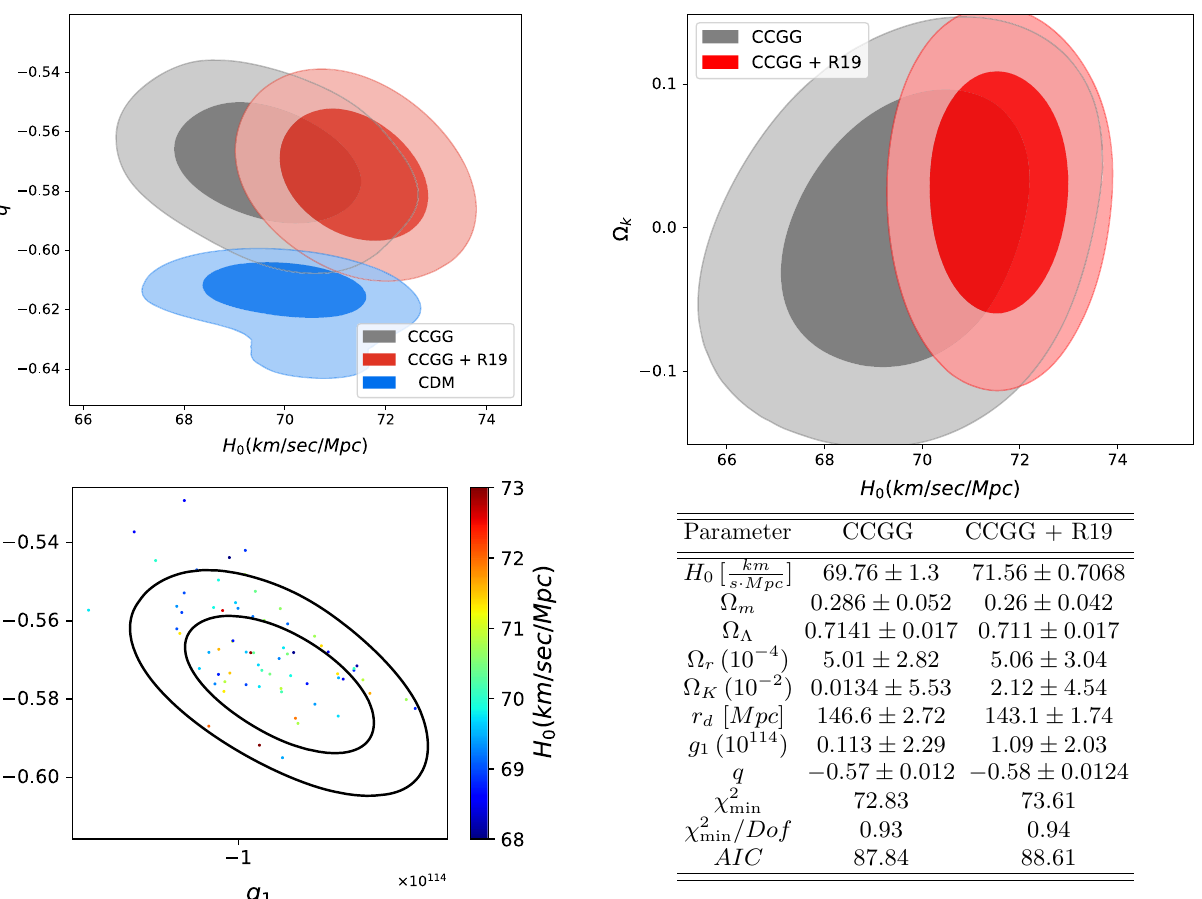
Fig. 5 One- (68% CI) and two-dimensional (68% and 95% CI) marginalized posterior distributions for the the deceleration parameter (cid:12) K vs.theHubbleparameter H 0 .ThegraycontourdescribestheCCGG best fit with a uniform prior. The red contour describes the CCGG best fit with the SH0ES measurement as a prior.The table shows Observa- tional constraints and the corresponding χ 2 for the CCGG model with min uniform prior and with the SH0ES prior with spatial curvature being 0 . 71 ± 0 . 09 or 0 . 72 ± 0 . 09 with the SH0ES prior, a